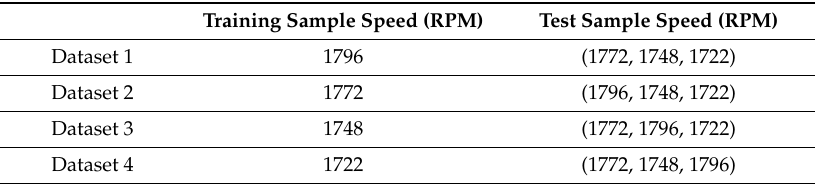
Table 1. Dataset for single bearing faults.